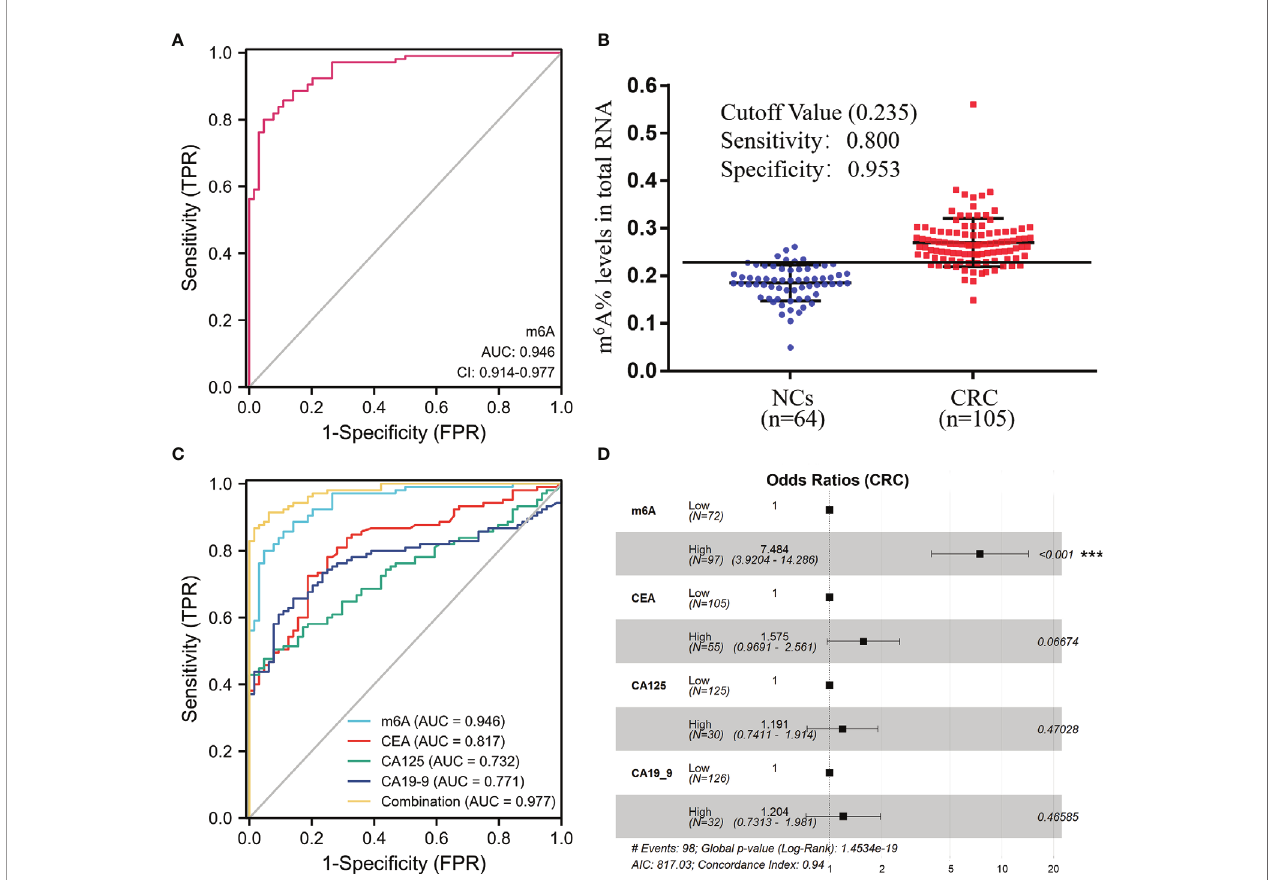
FIGURE 2 | Clinical utility for CEA, CA125, CA19-9, and the m 6 A RNA levels of peripheral blood immune cells to diagnose CRC patients. (A, B) ROC curve (A) and cutoff value (B) of the m 6 A levels of peripheral blood RNA in NCs ( n = 64) and CRC patients ( n = 105). (C) ROC curve of the m 6 A levels of peripheral blood RNA compared and combined diagnosis with CEA, CA125, and CA19-9. (D) Forest plot of multivariate logistic regression analysis demonstrated that the m6A levels were an independent factor associated with CRC diagnosis; *** p <